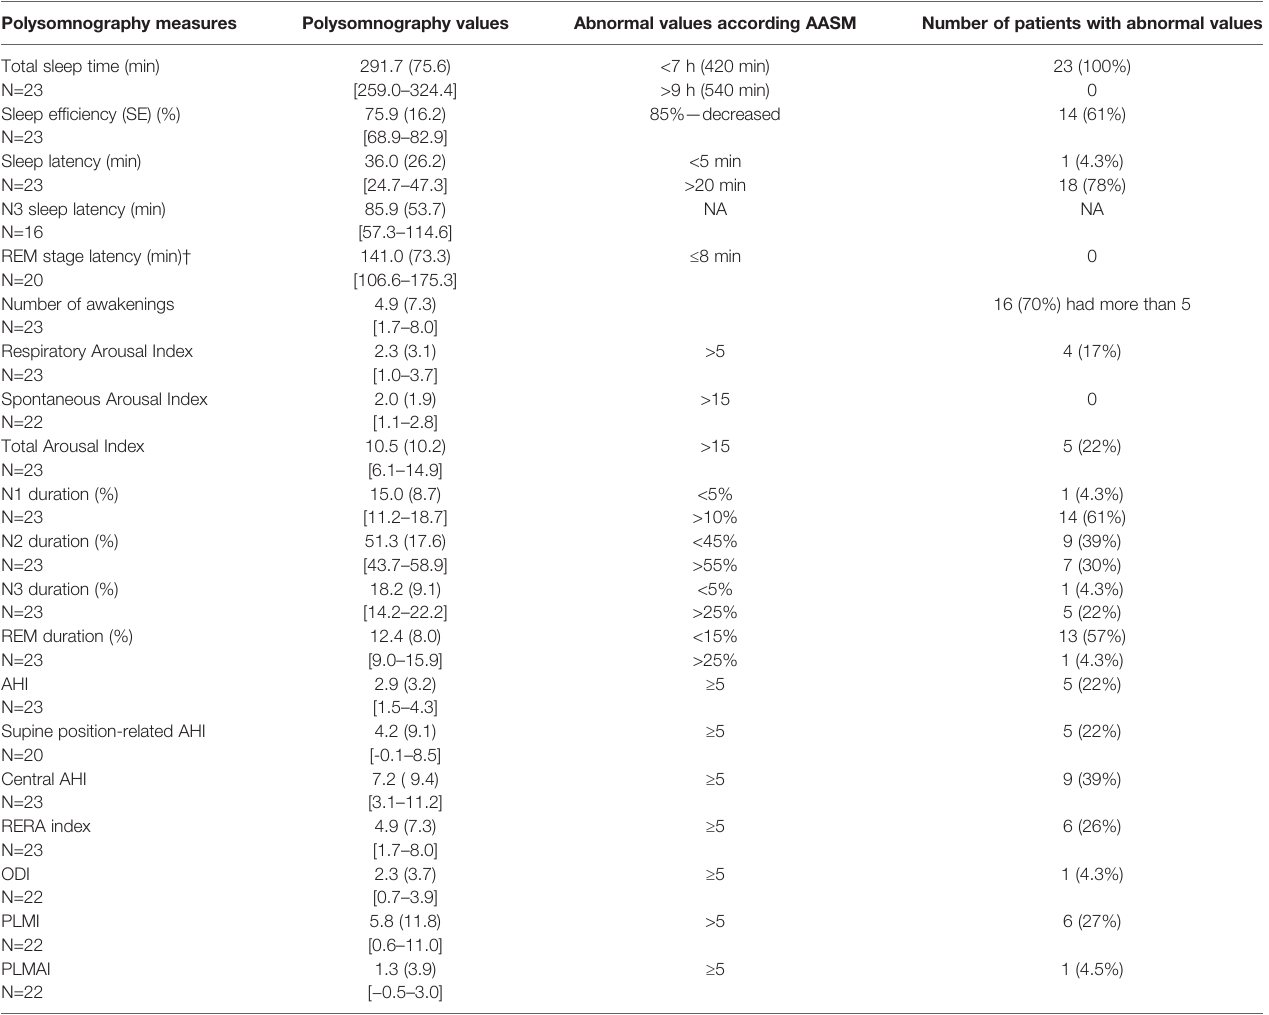
TABLE 3 | The results from polysomnography of ME/CFS patients and compared to normal values according to the AASM 2007 (25). Polysomnography measures Polysomnography values Abnormal values according AASM Number of patients with abnormal